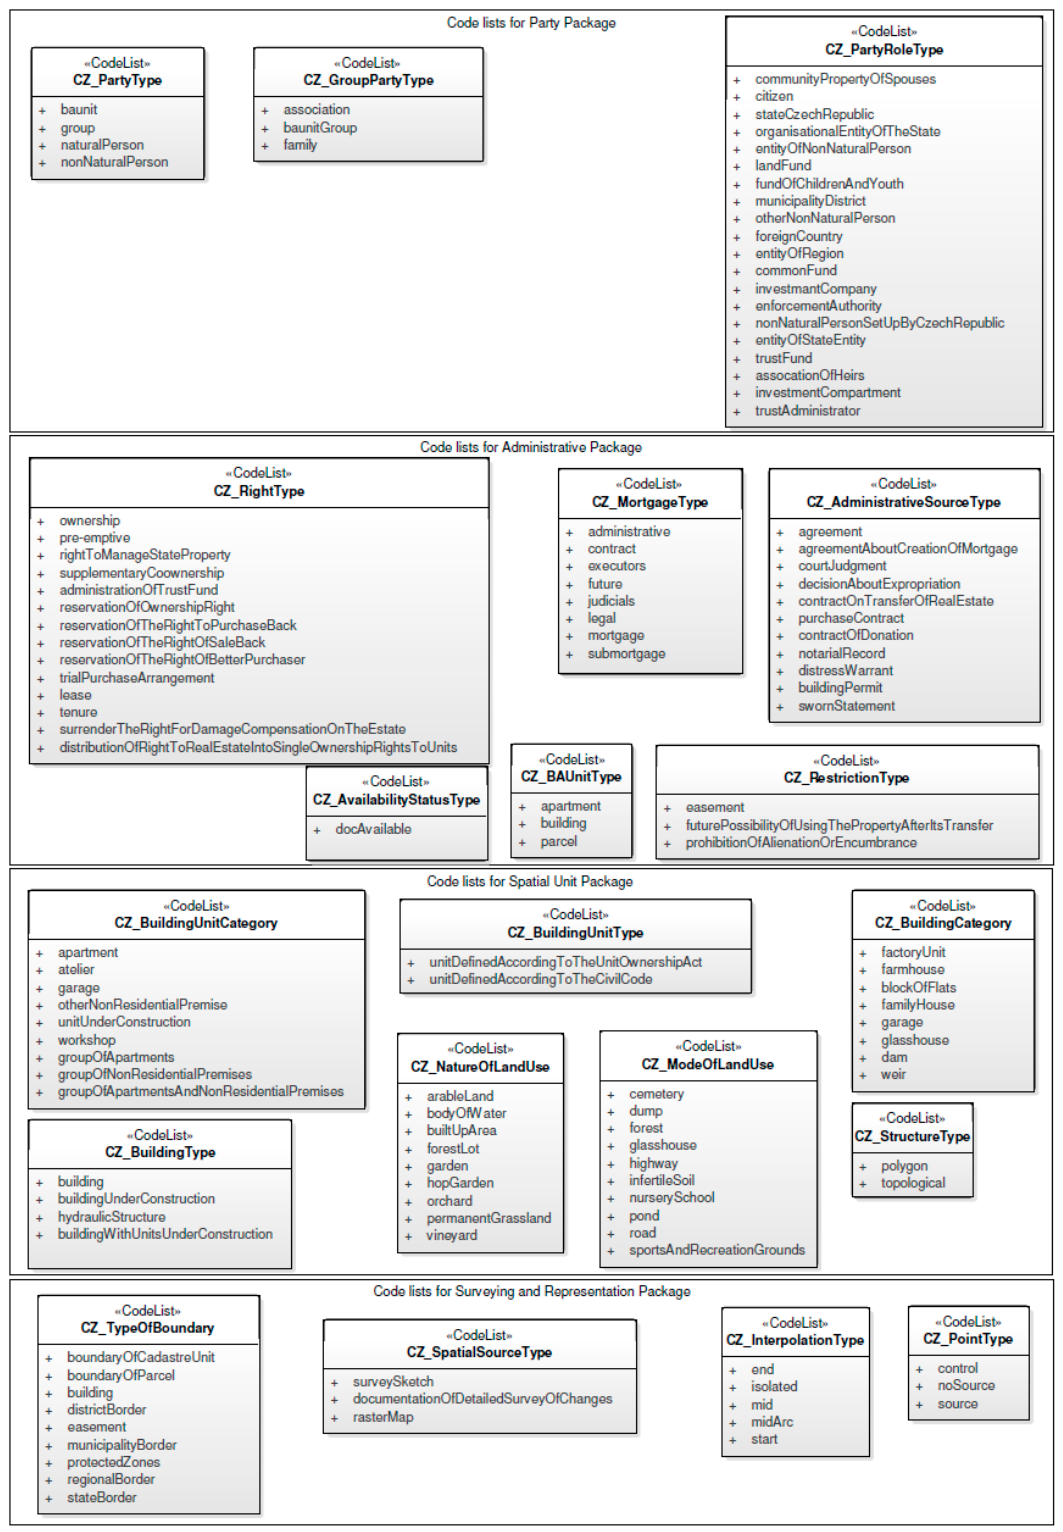
Figure 12. The code lists used in the Czech LADM-based country profile. In some cases, the presented code list contains only a subset of all of the possible values. For example, in reality, the LA_RightType code list contains more than 160 types of different types of right.